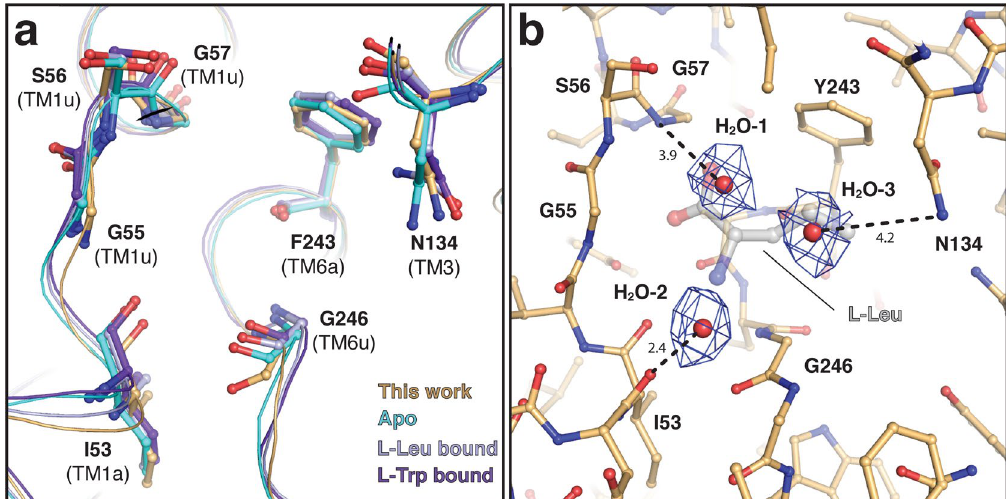
Figure 4. View into the substrate binding pocket of superimposed LAT2 structures and identified water molecules. ( a ) Ribbon representation (thin lines), and residues important for substrate recognition and binding (sticks) for the following 4F2hc-LAT2 heterodimer structures: apo (orange; this work), apo (cyan, PDB-ID: 7B00), L-Leu bound (light blue, PDB-ID: 7CMI) and L-Trp bound (violet, PDB-ID: 7CMH). ( b ) Substrate binding pocket of 4F2hc-LAT2::D11vs (this work) including the identified water molecules H 2 O-1, H 2 O-2 and H 2 O-3, and their respective cryo-EM densities. Displayed is also the substrate L-Leu (faint grey sticks) from the superimposed L-Leu bound 4F2hc-LAT2 structure (Supplementary Fig. S4b). Structural representations were prepared using PyMol (version v2.5.2; The PyMol Molecular Graphics System, Schrödinger). The figure was assembled and labeled using Adobe Illustrator 26.5 (https:// adobe. com/ produ cts/ illus